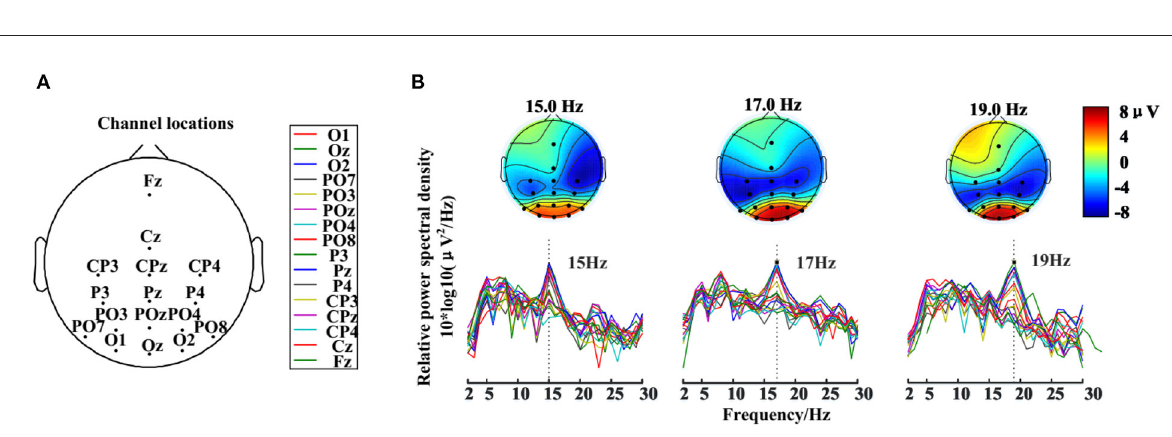
FIGURE10 The spatial distribution and power spectral density (PSD) spectrum of the SSVEP feature. (A) 16-electrode locations were selected in the experiment. (B) PSD spectrum of 16 channels and its corresponding scalp topographies in different stimulus frequencies.